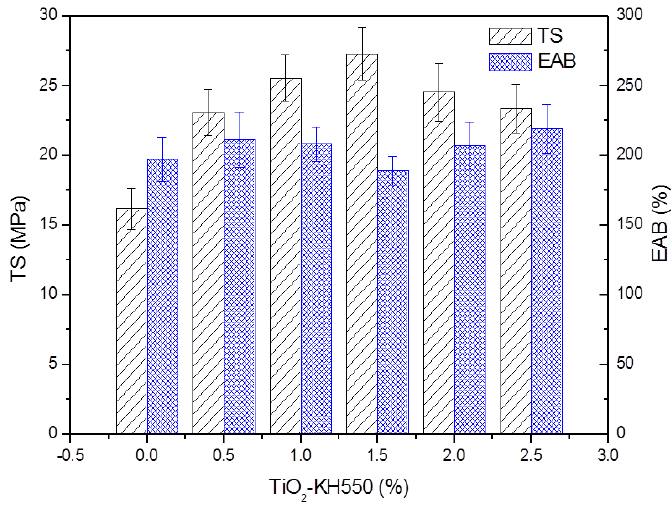
Figure 5. Mechanical properties of the composite films (KT0~KT2.5).